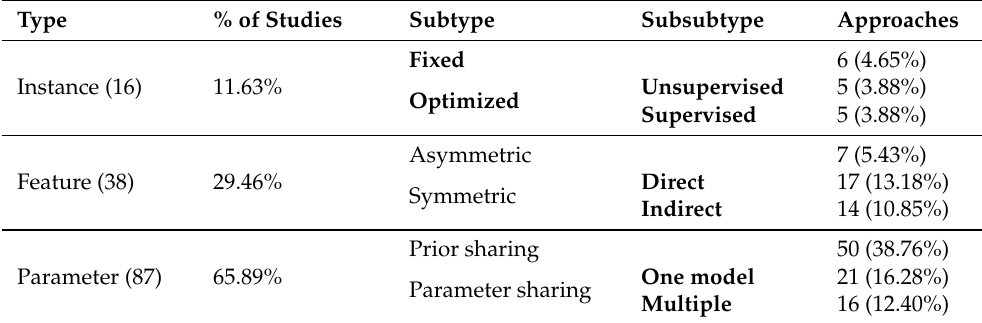
Figure 3. ( Left ): Number of articles according to the ML method studied (methods enumerated in Section 4.2). ( Right ): Dis- tribution of articles according to the publication year. Table 4. Transfer learning strategies categorization. Bold font highlights the proposed